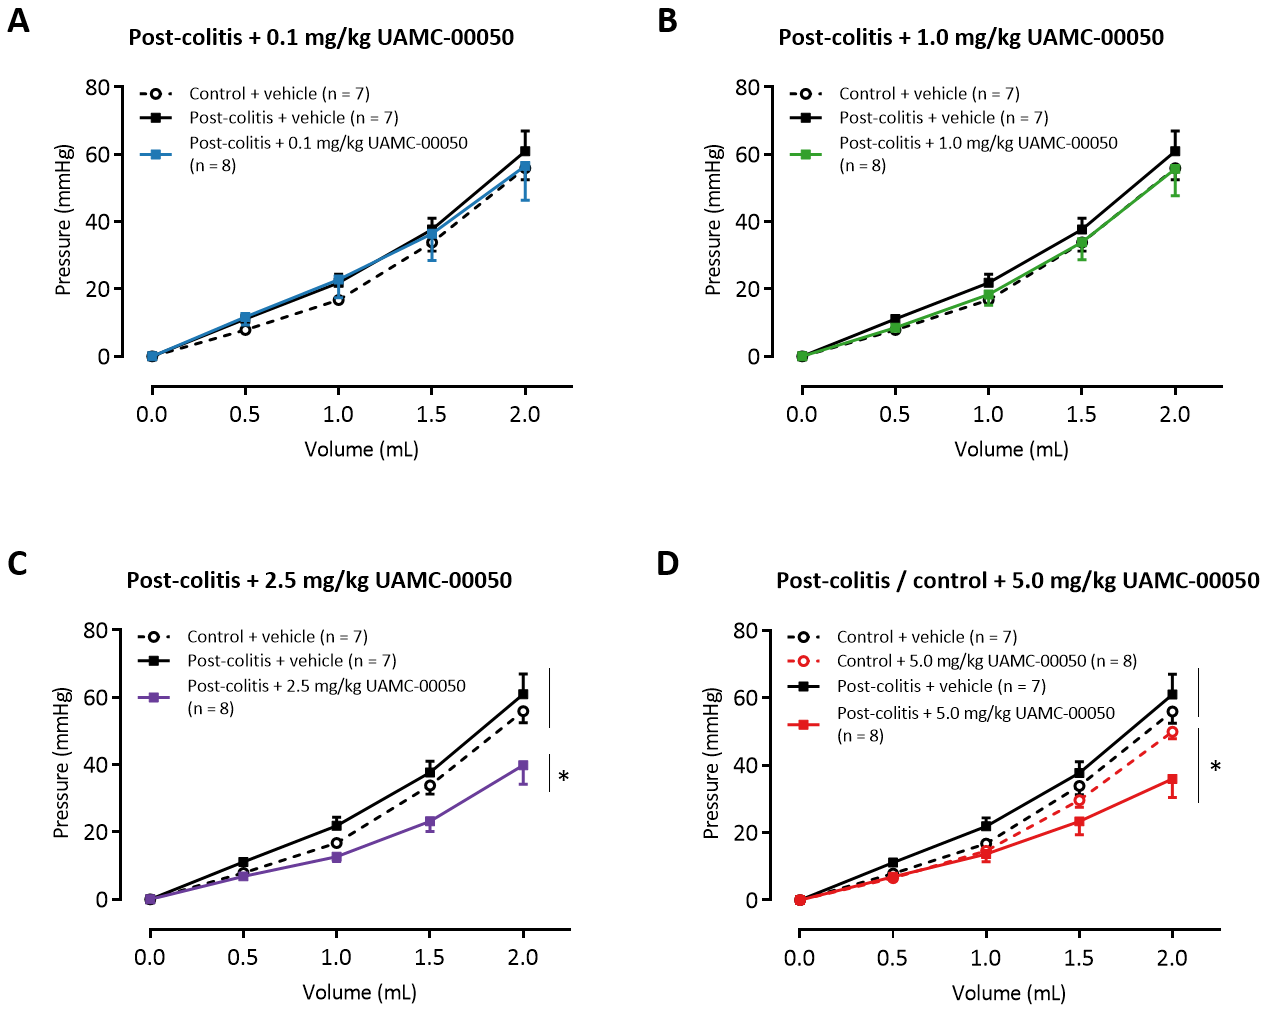
Figure 8. The effects of intracolonic administration of UAMC-00050 (0.1 ( A )–1.0 ( B )–2.5 ( C )–5.0 ( D ) mg/kg) and its vehicle (5% DMSO in H 2 O) on colonic compliance in post-colitis (filled squares) and control (open circles) rats. Statistical analysis was performed on the complete dataset, however separate graphs were generated for each dose for the purpose of clarification. Data are presented as mean ± SEM. Generalized estimating equations using an unstructured working correlation matrix, followed by a least significant difference (LSD) post hoc test; n = 7–8 per group. Note: * p < 0.05; significantly different from vehicle treated animals.